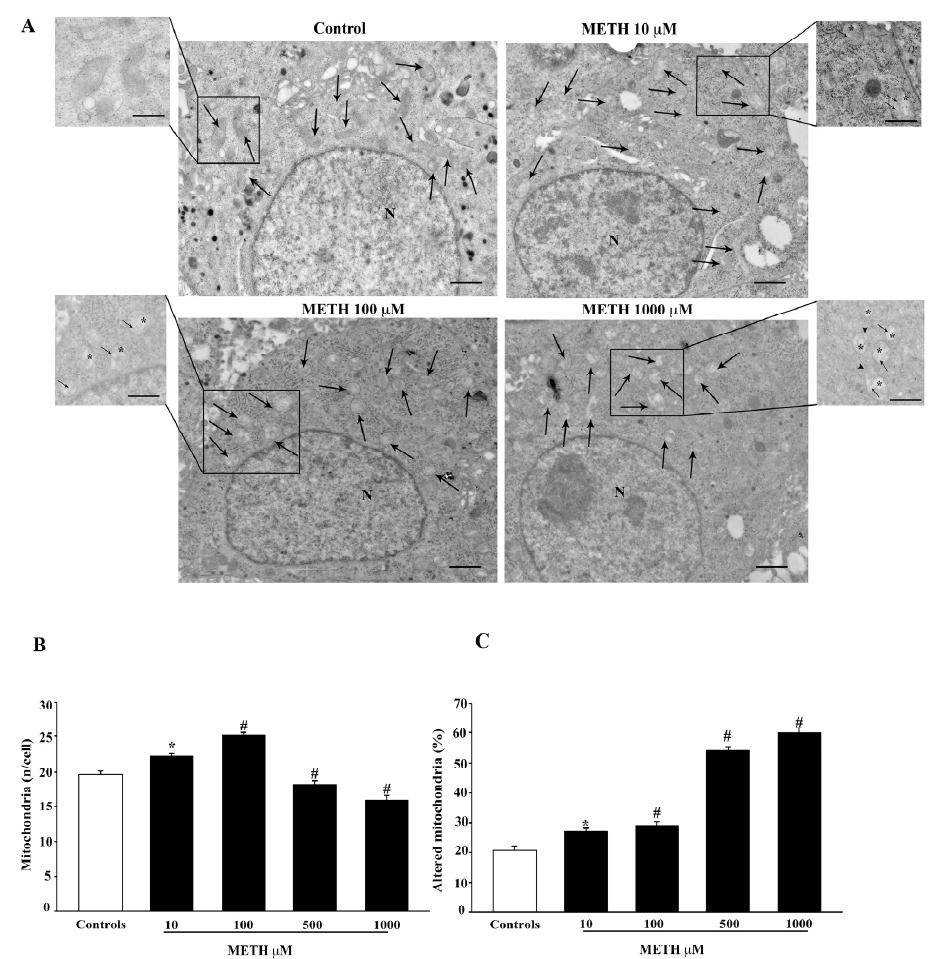
Figure 6. METH produces dose-dependent mitochondrial alterations. ( A ) Representative TEM micrographs showing mitochondria (arrows) in control and after increasing doses of METH. Inserts at high magnification show details of mitochondrial ultrastructure for each experimental group, such as matrix dilution (*), broken crests (arrows) and ruptures of membranes (arrowheads). ( B ) The graph reports the total number of mitochondria after increasing doses of METH (from 10 μ M up to 1000 μ M). ( C ) The graph reports the dose-dependent increase in altered mitochondria following METH. Values are given either as the mean ± S.E.M ( B ) or as the mean percentage ± S.E.M. ( C ) from N = 50 cells per group. * p ≤ 0.05 compared with controls; # p ≤ 0.05 compared with controls and METH 10 μ M. Scale bars = 500 nm; 280 nm (inserts).